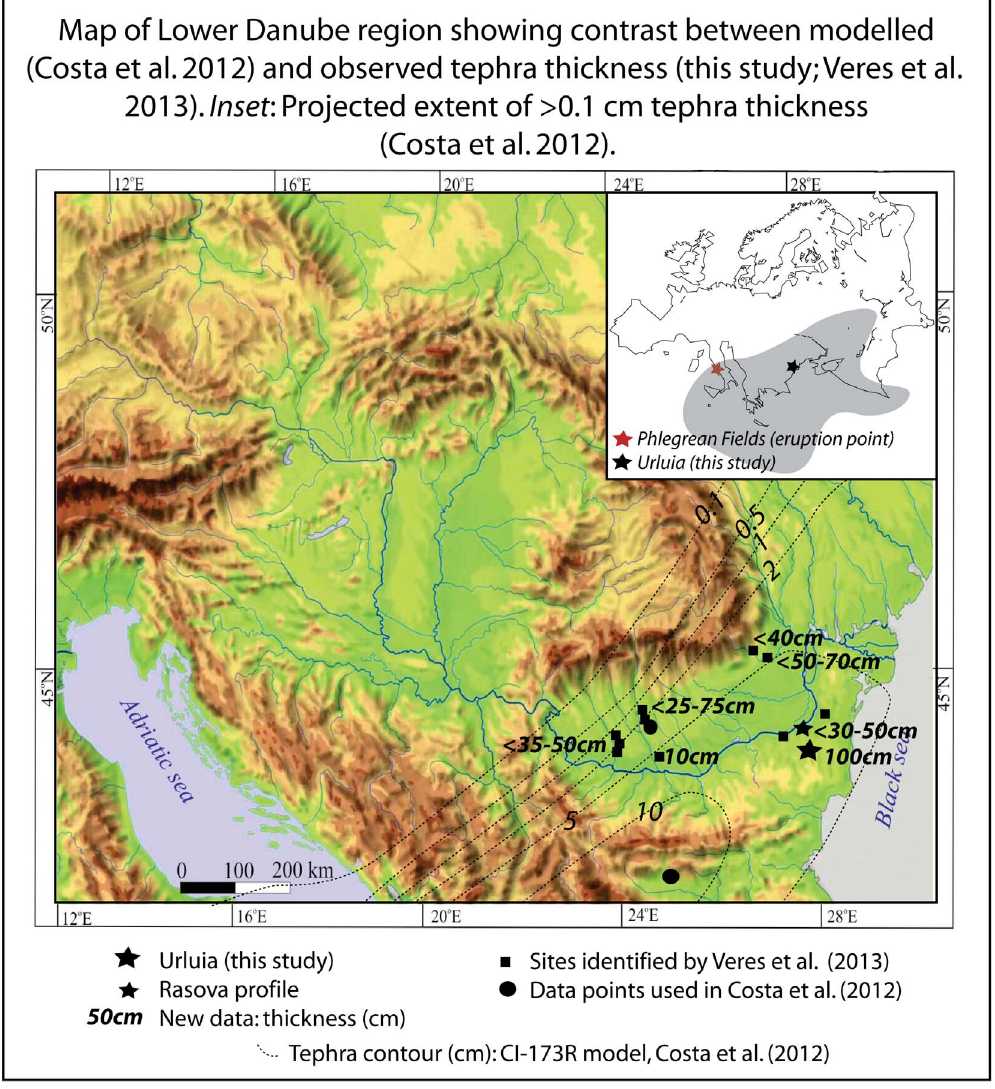
Figure 1. Map of the Lower Danube region showing the contrast between modelled [ 12 ] and observed thickness of the CI tephra (this study; [ 5 ] ). Inset shows the projected extent of . 0.1 cm tephra thickness, based on data from [12].